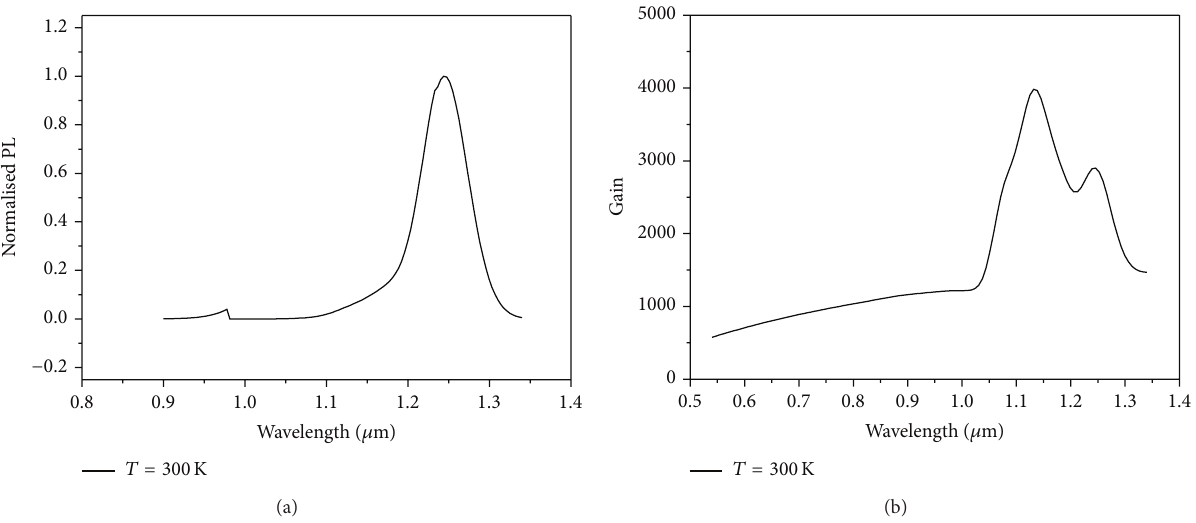
Figure 3: (a) Simulated PL spectrum. (b) Absorption layer gain spectrum.